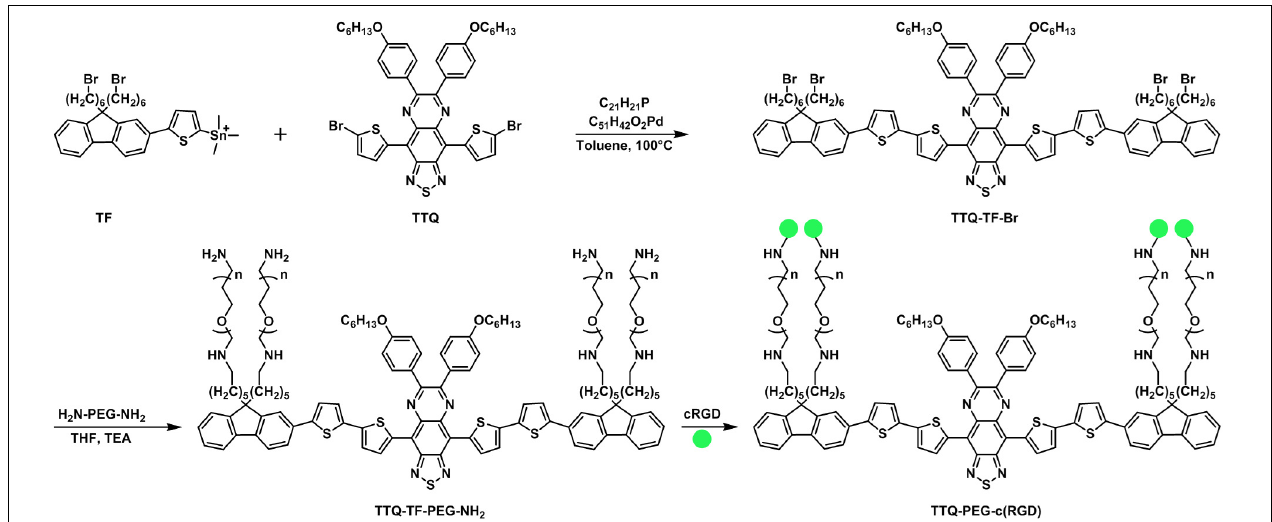
FIGURE 2 | Synthetic scheme for